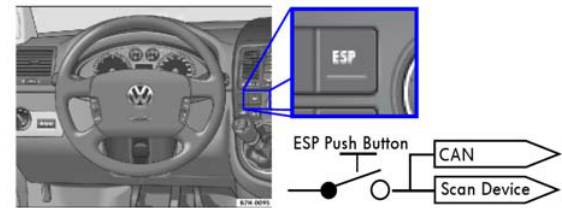
Figure 6. ESP Push Button in Volkswagen T5 and connection diagram